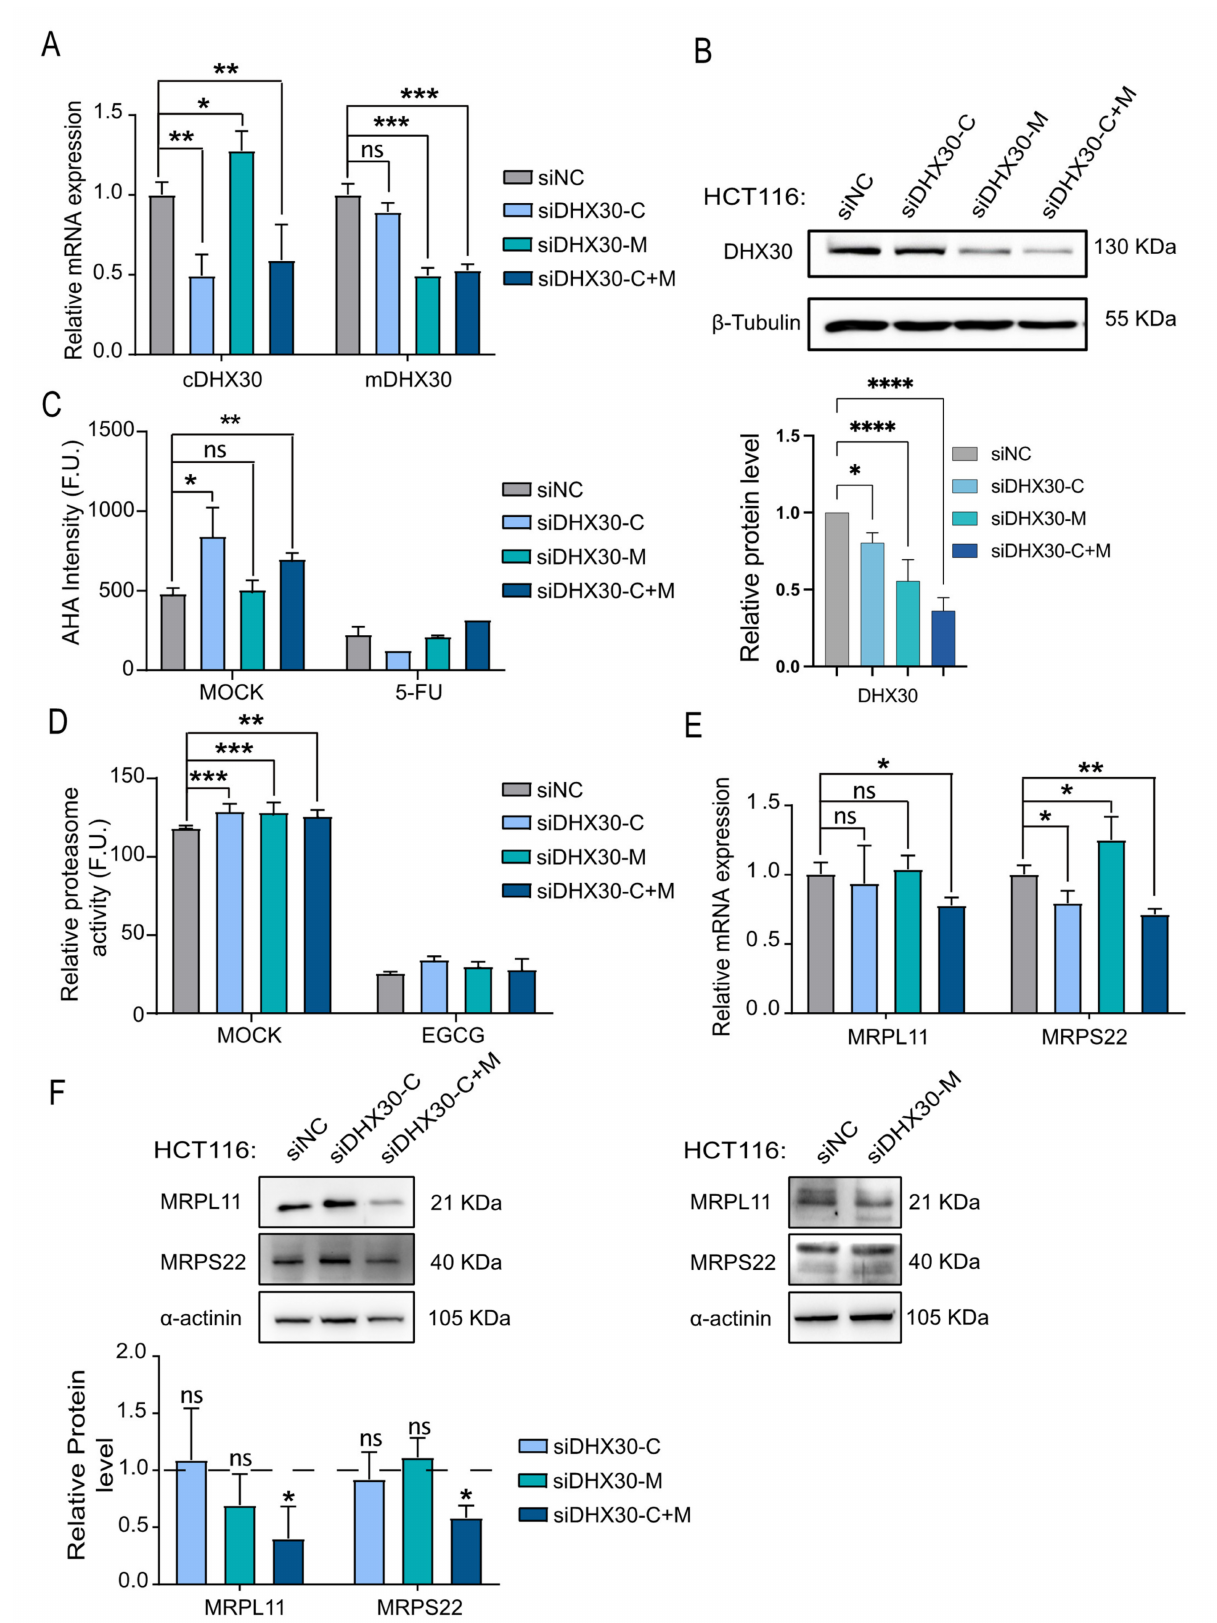
Figure 4. Transient DHX30 silencing leads to enhanced translation but reduced mitoribosome gene expression in HCT116 cells. ( A ) RT-qPCR to verify the silencing of DHX30 transcripts in HCT116 96 h after transient transfection with the